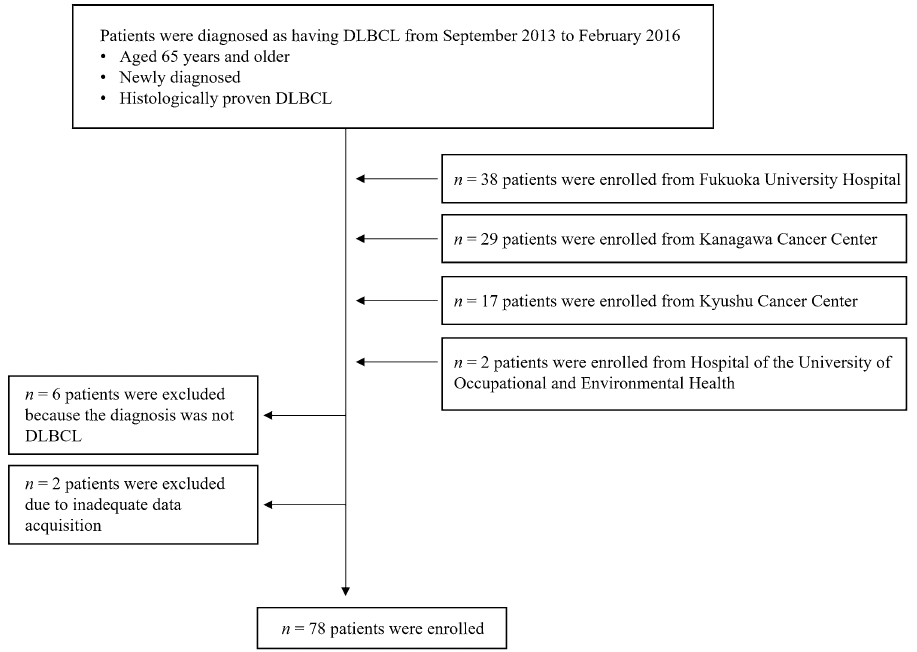
Figure. 1. Flow diagram of patients. In four participating institutions, 86 patients aged ≥ 65 years were initially diagnosed with DLBCL from 2013 to 2016. A total of eight patients did not have adequate data, and the